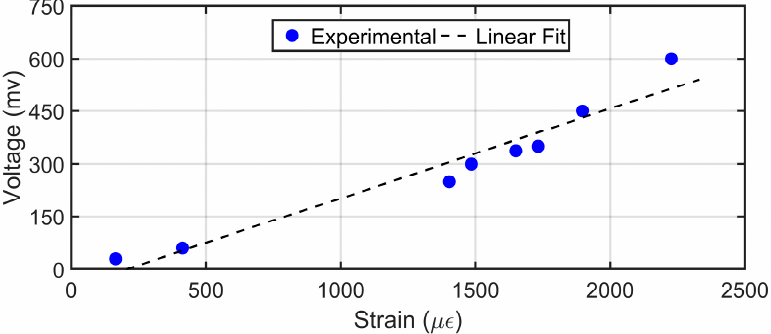
Figure 8. Relationship between voltage output and strain induced with di ff erent tip displacement in the PVDF sensor in cantilever configuration.